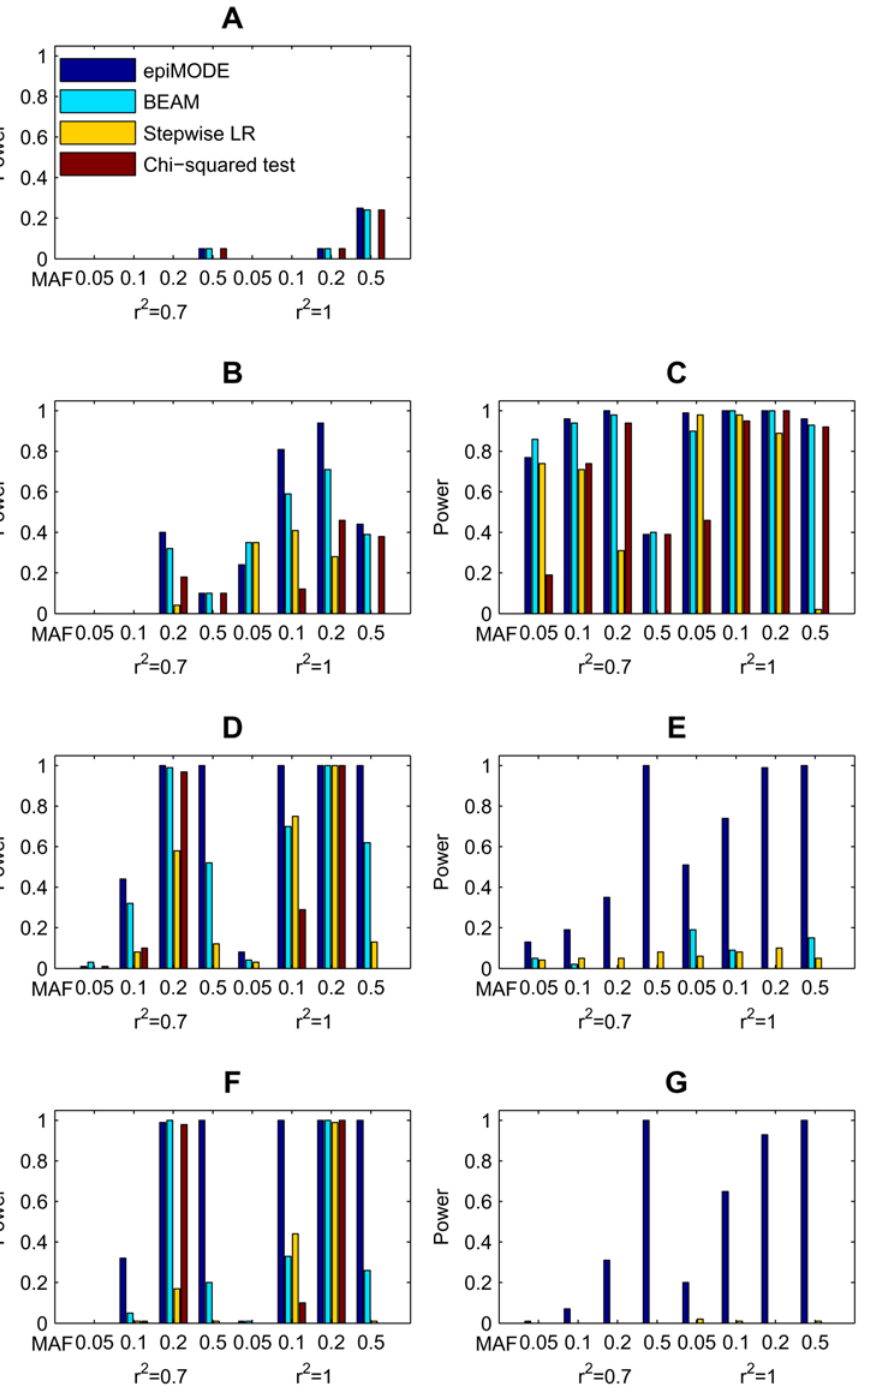
Figure 2. Comparison of epi MODE, BEAM, stepwise logistic regression (LR), and the classical single-locus Chi-squared test on seven disease models (A–G). For each parameter setting, the power is calculated as the proportion of simulated data sets in which all markers associated with the causative SNPs are indentified at the significance level 0.05 after Bonferroni correction. Each data set contains 1,000 cases and 1,000 controls, in which 1,000 markers are genotypes for each subject. The absence of bars stands for zero power.